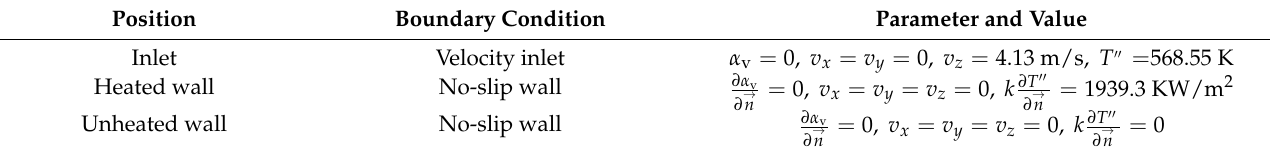
Table 1. Boundary